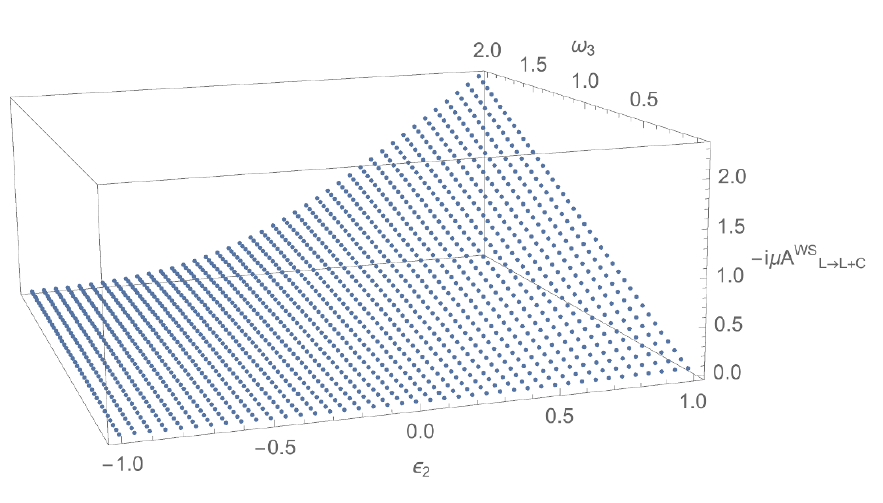
Figure 4 . The long ! long + closed string amplitude A L ! L + C (rescaled by (cid:22) ) as a function of the outgoing long string energy (cid:15) 2 and the closed string energy ! 3